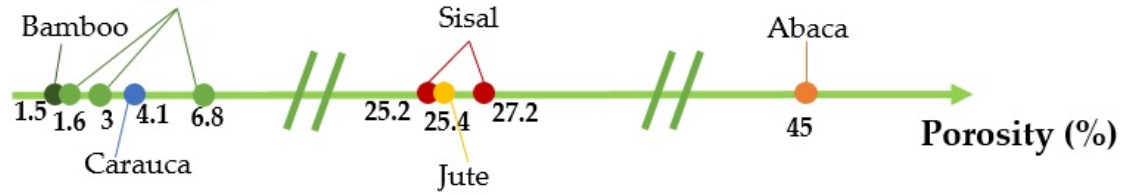
Figure 1. Lumen/total surface ratio (%) for different plant fibres; from [1,12–16]